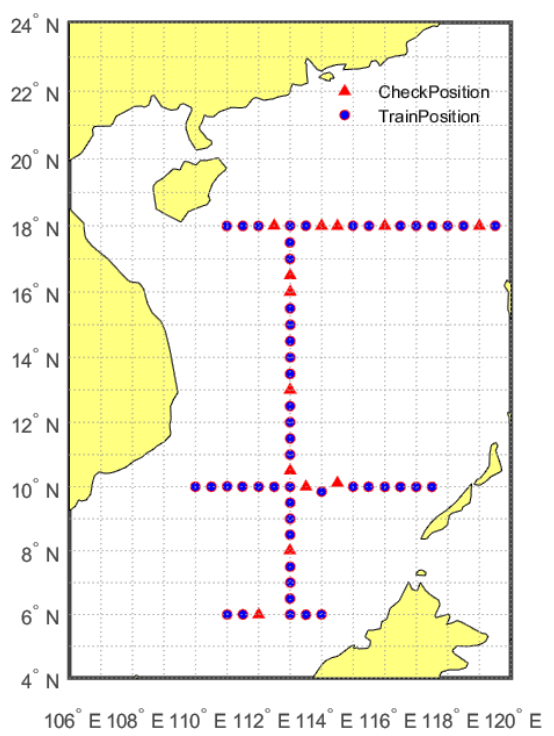
Figure 2. Classification of selected sites.